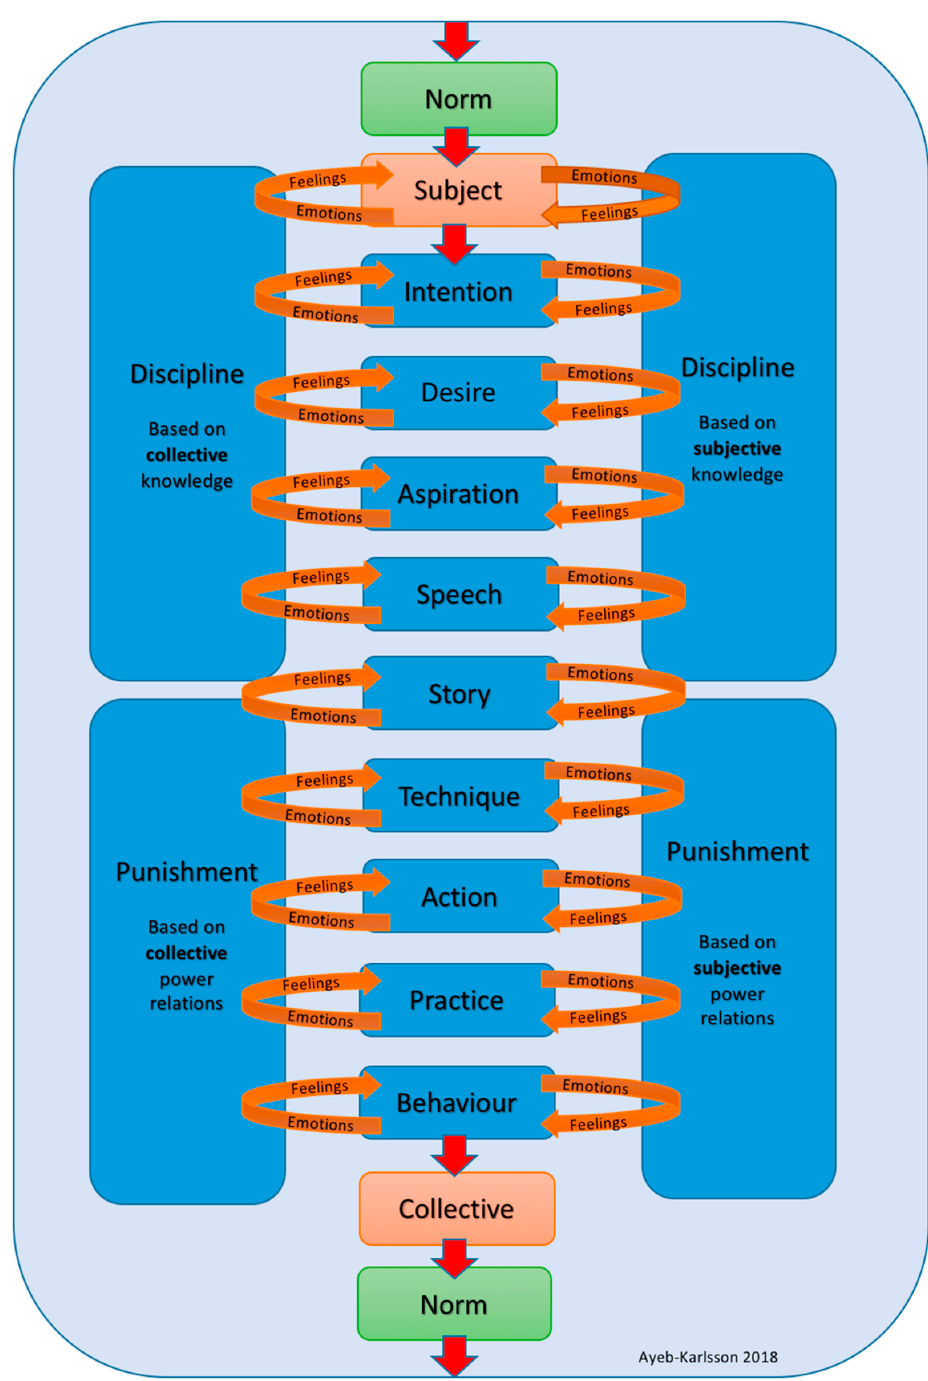
Figure 2. Discursive decision-making model.